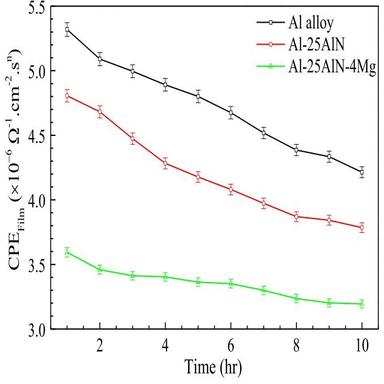
Effect of Mg and AlN composite on (a) passive layer and (b) double layer CPE magnitudes of the alloy in 0.1 M NaCl solution as a function of elapsed time.